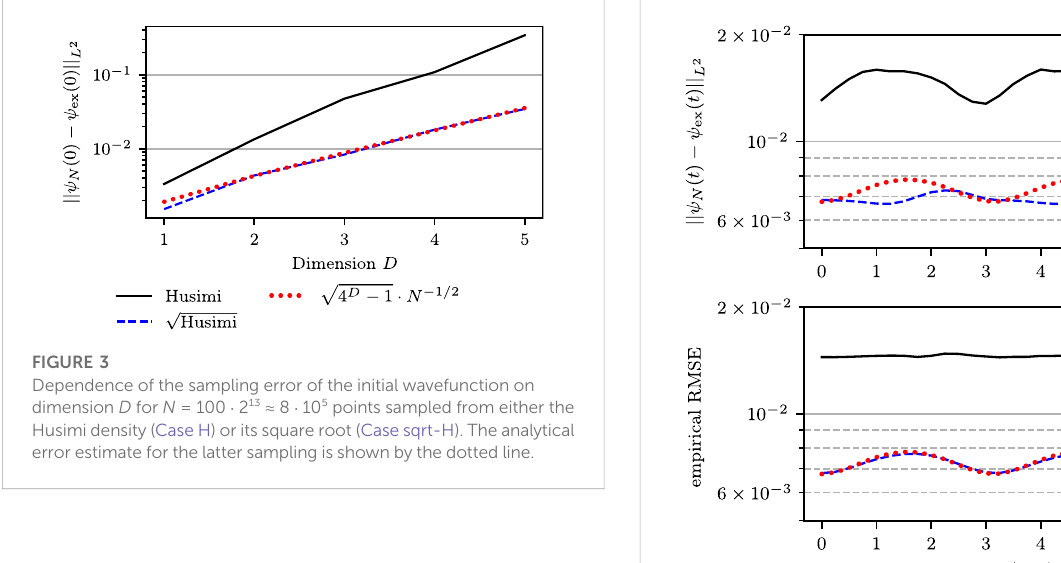
FIGURE 4 Time dependence of the sampling error of the Herman – Kluk wavefunction propagated in a harmonic oscillator. The upper panel is produced by one run with N = 2 16 = 65,536 trajectories, whereas the lower panel is produced by K = 100 independent runs, each with N = 2 16 = 65,536 trajectories, and averaging the square of the error overthe K runs.Theanalyticalerrorestimateforthesamplingfromthe square root of the Husimi density (Case sqrt-H) is shown with the dotted